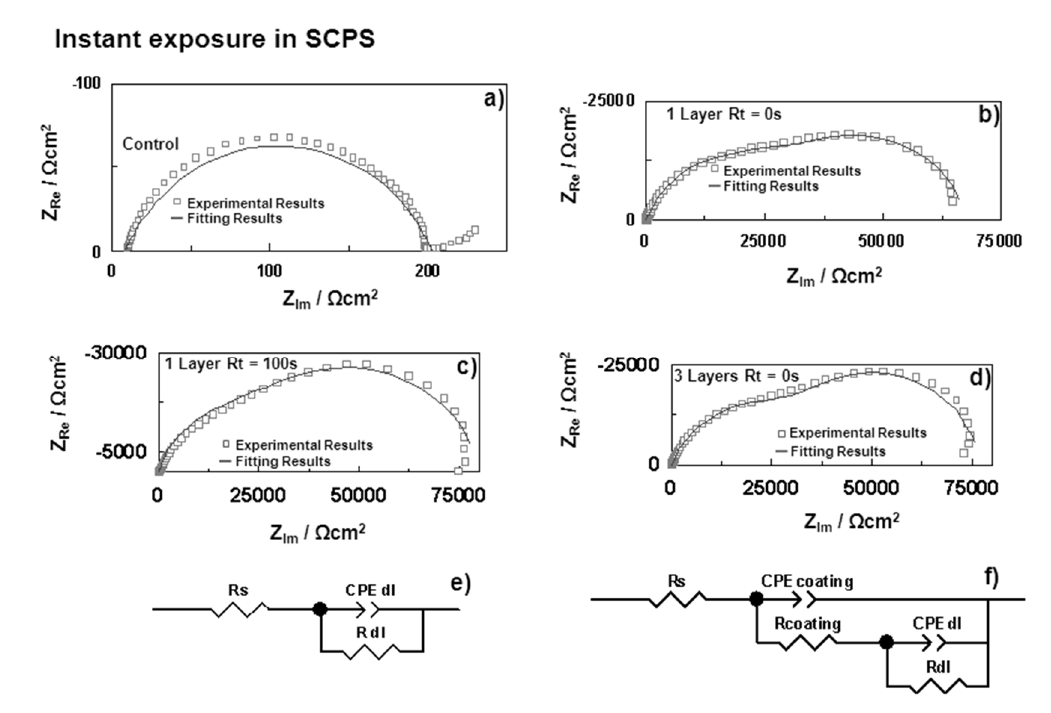
Figure 5. Nyquist plots for: ( a ) Control and U(400) coated HDGS samples by one dip step: ( b ) Rt = 0 s and ( c ) Rt = 100 s; ( d ) HDGS samples coated by three consecutive dip steps and Rt = 0 s in the instants of exposure to SCPS. EECs used for numerical fitting of the Nyquist plots for: ( e ) Control and ( f ) coated HDGS samples.